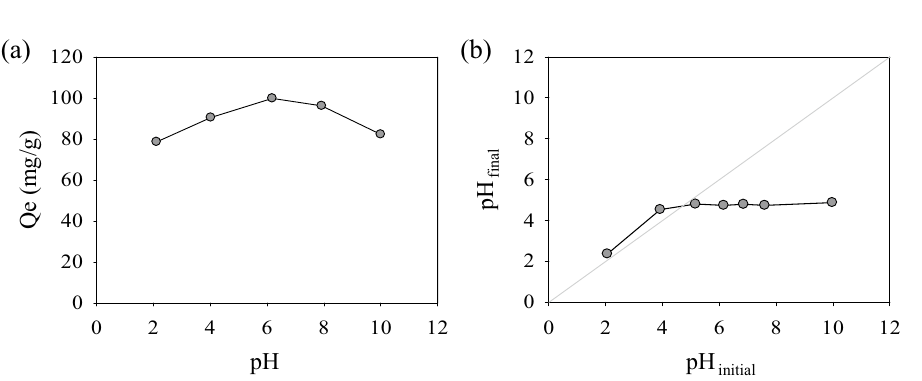
Figure 3. ( a ) Effect of initial pH on the adsorption of MB and ( b ) pH pzc determination plot of N g